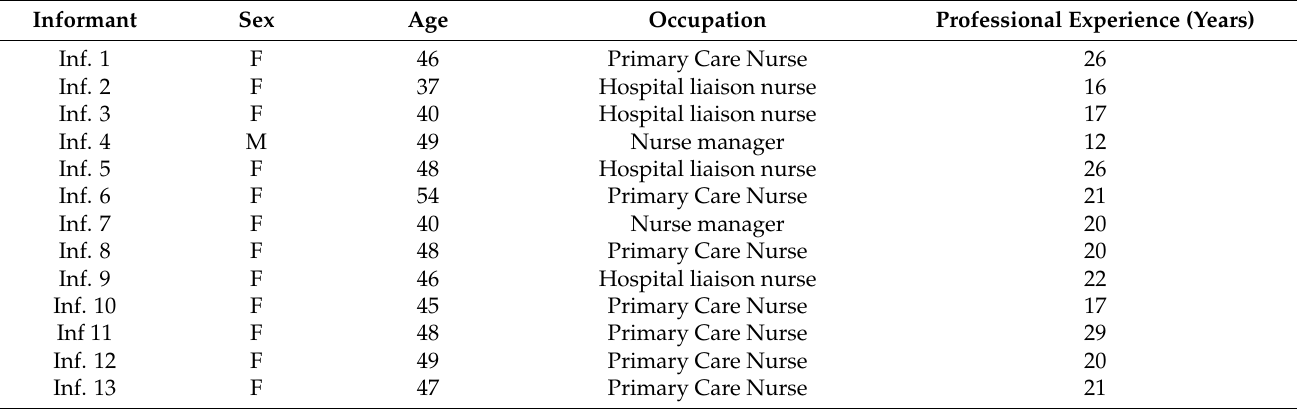
Table 2. Profile of informants.